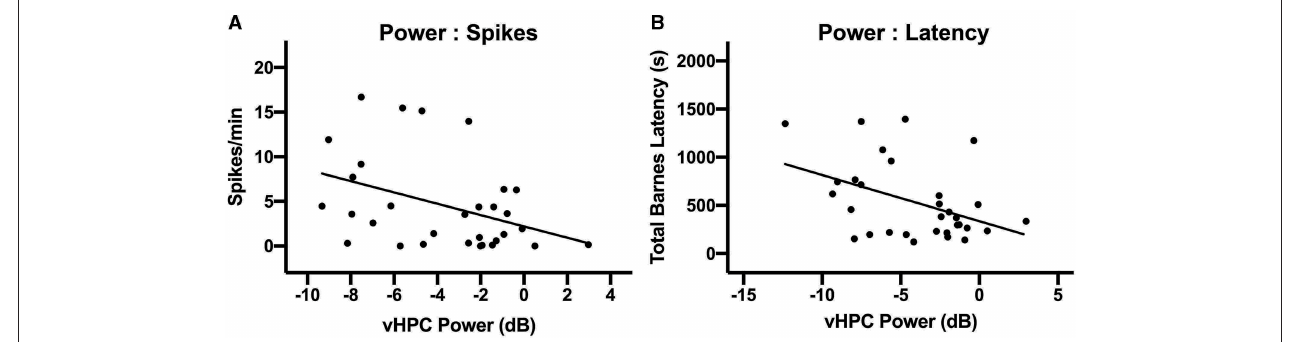
FIGURE 6 | Relationship between vHPC power, behavioral performance, and spikes. (A) There was a significant linear relationship between vHPC power (6–10Hz) on PPD31 and the development of spikes ( p < 0.05). (B) vHPC Power (6–10Hz) on PPD31 was also significantly correlated with total Barnes maze latency ( p <